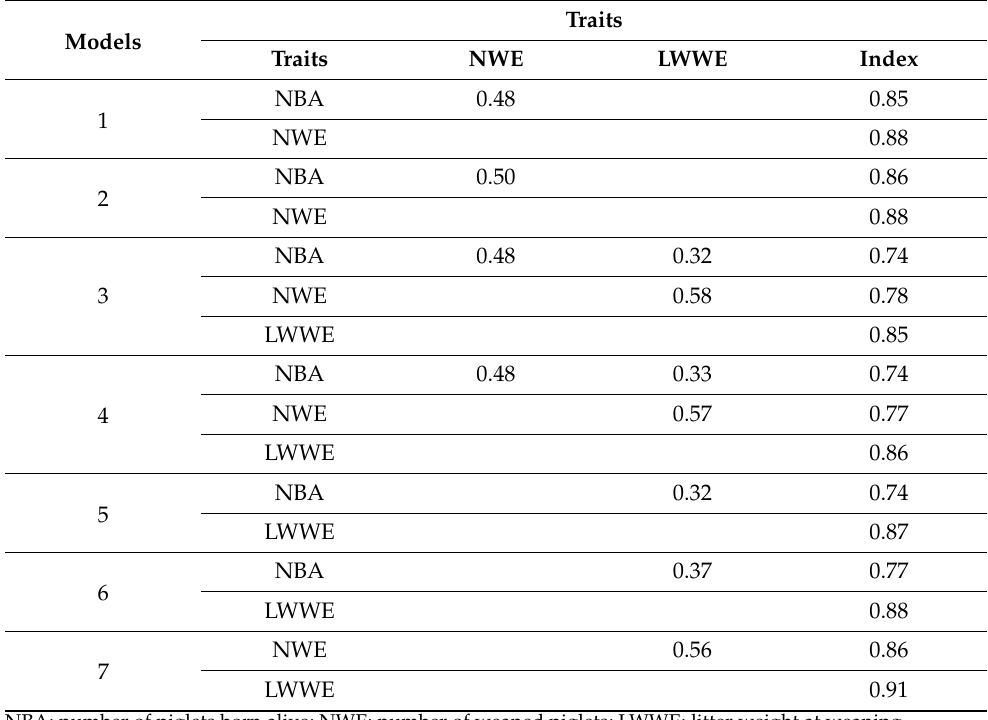
Table 10. Genetic correlation coefficient (Pearson’s correlation) between examined traits and the selection index scores for the HLW (Pr > |t| < 0.0001).